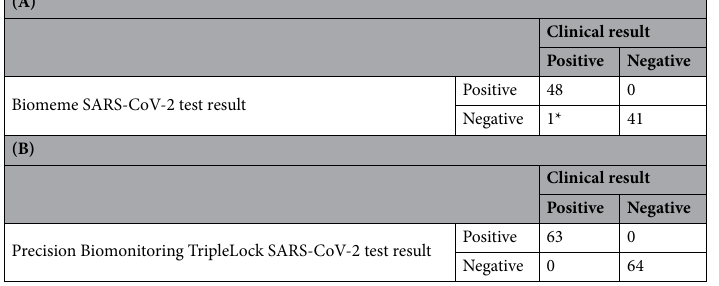
Table 4. Evaluation of clinical sensitivity and specificity with the mix of known positive and negative clinical samples. Following the evaluation of the clinical performance of the two assays using known positive and negative clinical samples, the clinical sensitivity and specificity of the Biomeme (A) and Precision Biomonitoring TripleLock (B) SARS-CoV-2 assays were calculated.